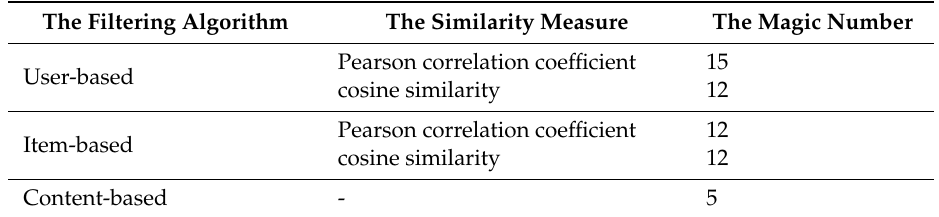
Table 15. The magic number of each filtering